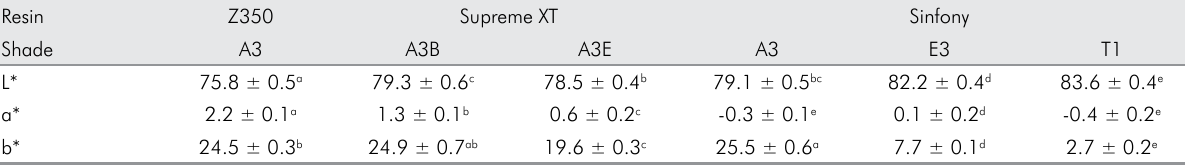
Table 2. Means and standard deviations of L*, a*, and b* values of each layer constituting resin overlays.